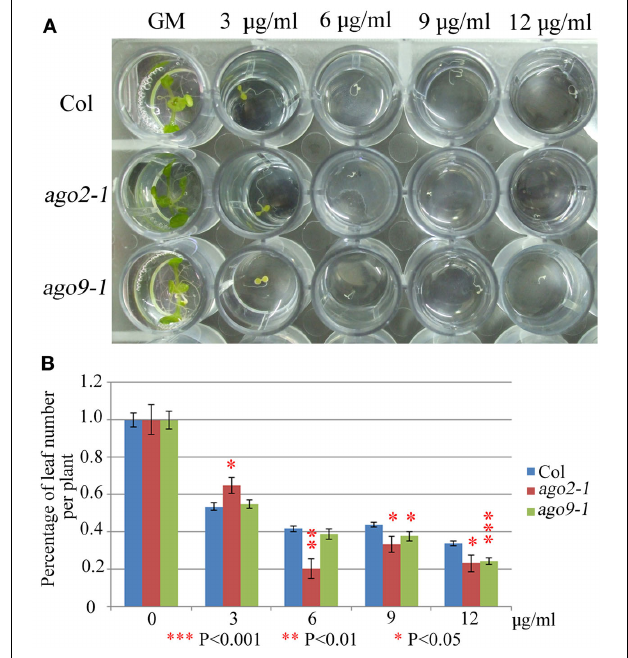
FIGURE 6 | ago2-1 and ago9-1 are hypersensitive to MMC. (A) Phenotypes of 16-day-old seedlings ( ago2-1, ago9-1 , and Col) grown on liquid media containing different concentrations of MMC. (B) Percentage of leaf number per plant after treatment with different concentrations. Leaf number at each dose was scored and put into relation to the leaf number of the untreated plantlets of the same line. Mean values and standard errors are depicted. Asterisks indicate P -values from t -Student tests: ∗∗∗ P < 0 . 001, ∗∗ P < 0 . 01, and ∗ P < 0 . 05. See Supplementary Table S2 for more